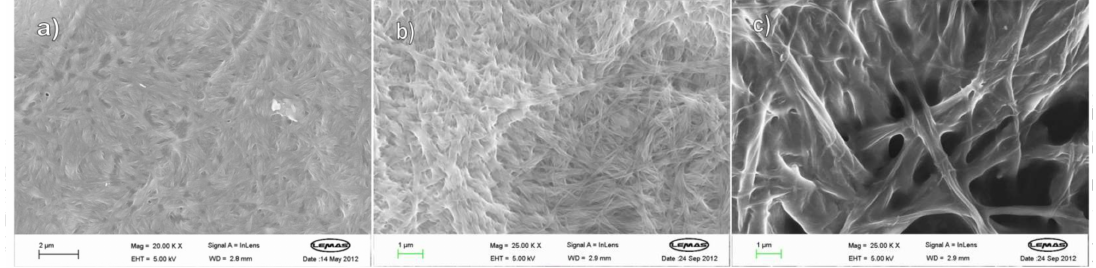
Figure 5. FEG-SEM images of xerogels formed by C8 and, ( a ) L,L,L; ( b ) D,D,D; ( c ) racemic mixture